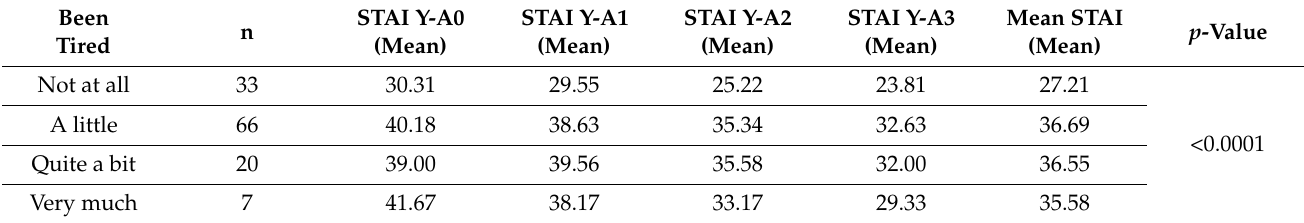
Table 3. Influence of the level of fatigue explored with the QLQC-30 inventory on the level of anxiety. Been